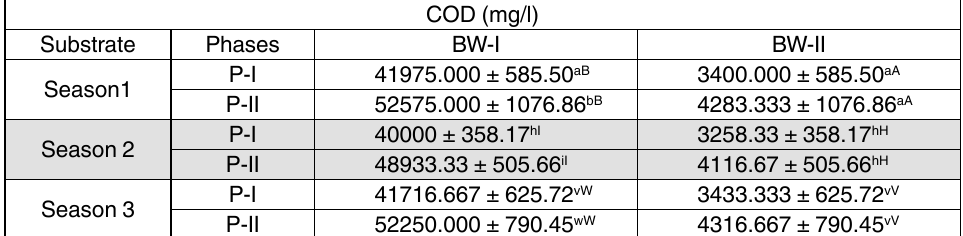
Table 4. Estimated COD (mg/l) of poultry slaughter waste and food